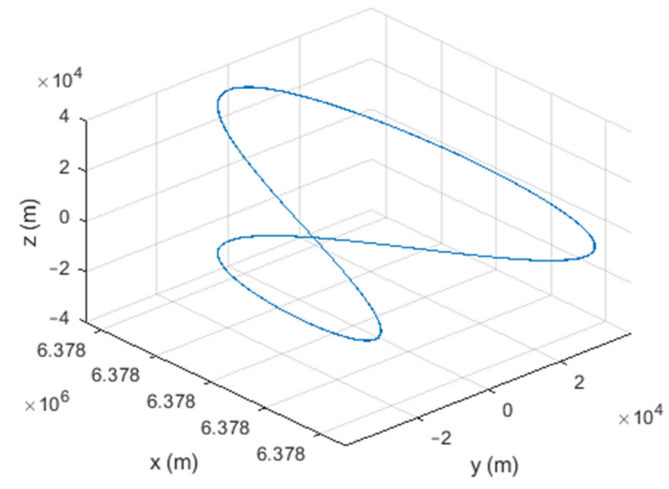
Figure 7. The fourth scenario: moving in a circular path at a speed of 3500 m/s.